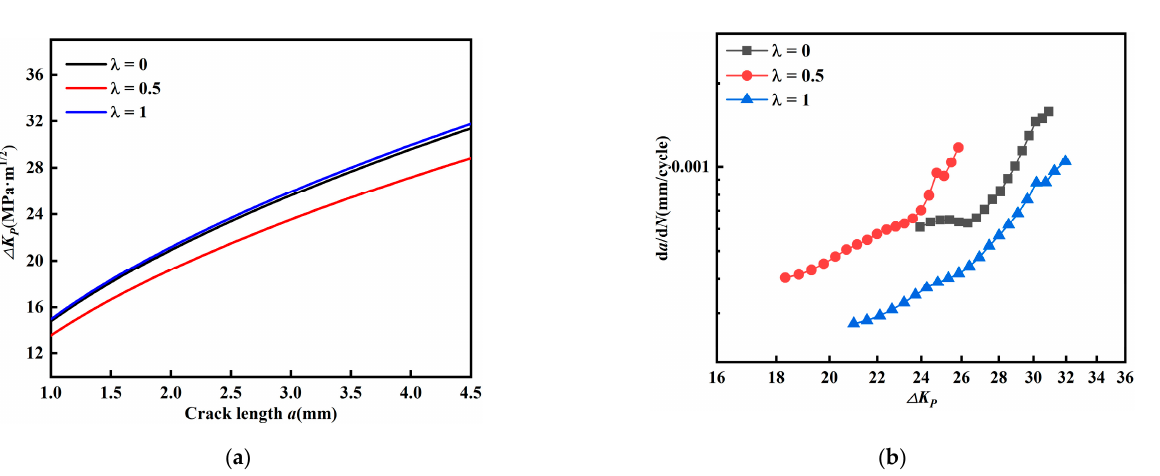
Figure 15. Richard model. ( a ) Relationship between a and △ K R ( β = 60°). ( b ) Relationship between a and △ K R ( β = 60°).